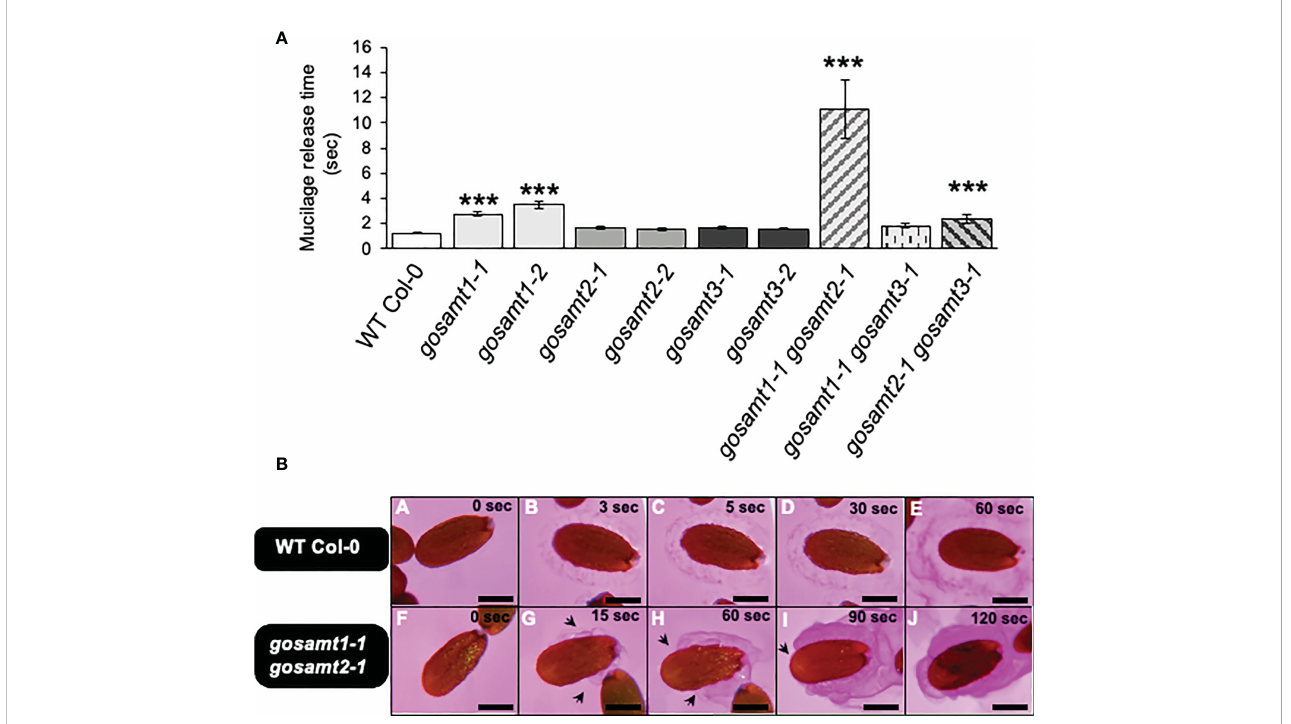
FIGURE 2 Mucilage release onset time of wild-type and gosamts mutants dry seeds. (A) Timing of mucilage release performed on mature seeds incubated in a Ruthenium red solution at 21°C. Error bars represent SE for four biological replicates ( n = 80). Statistical analysis of single comparisons against WT Col-0 performed by Mann-Whitney test (*** P < 0.001). (B) Images of mucilage release progression in Ruthenium red recorded in WT Col-0 (i.e., A – E) and gosamt1-1gosamt2-1 double mutant (i.e.,F – J); arrows indicate partial extrusion of soluble mucilage. Scale bars: 200 m